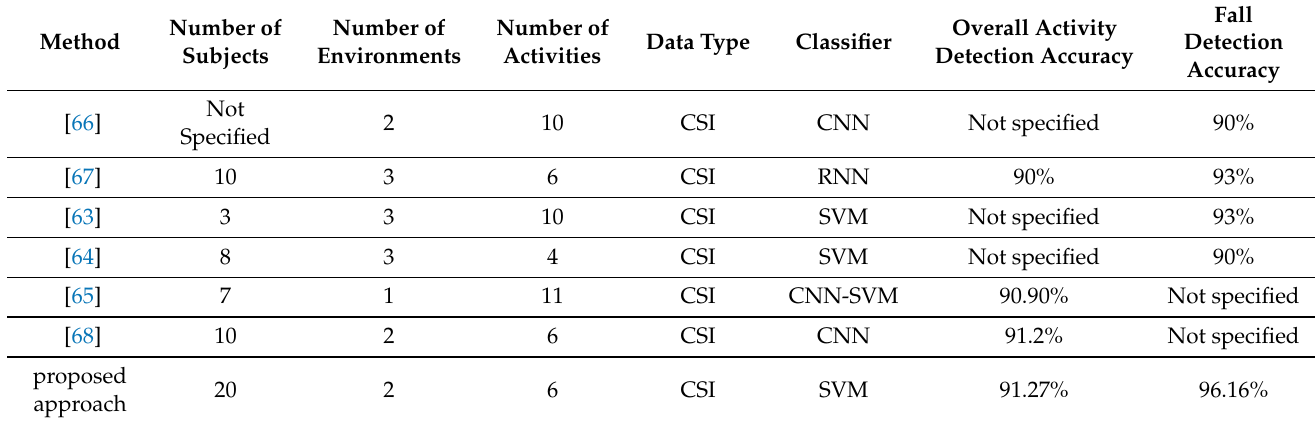
Table 16. Comparison with other existing